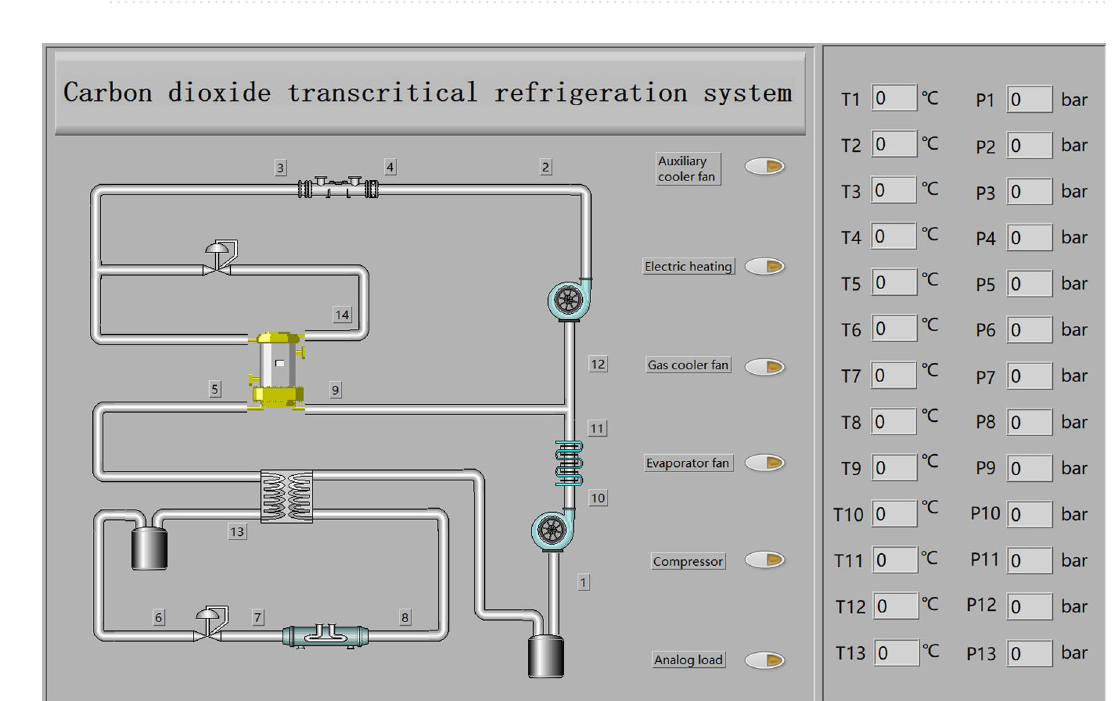
Figure 8. LabVIEW operation